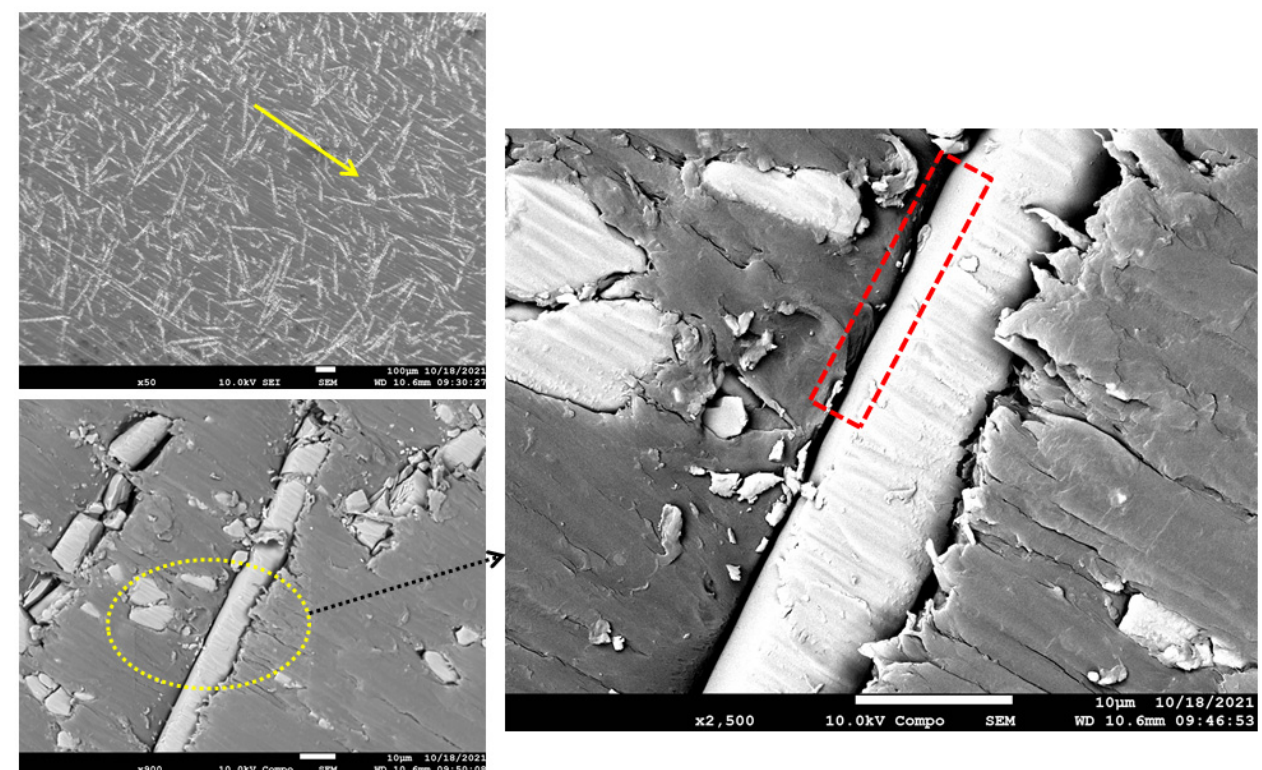
Figure 15. FESEM Micrographs for the worn-out surfaces of PA625GF at different magnifications.